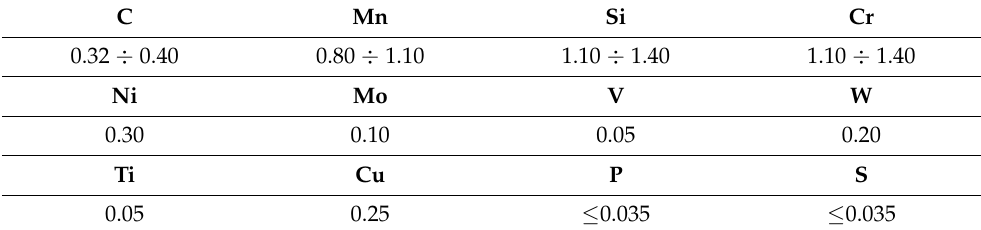
Table 4. Mechanical properties of 35HGS steel (according to PN-72/H-84030). Quantity Mark After Quenching and Tempering Tensile strength R m ≥ 1620 MPa Yield point R e ( R p0,2 ) ≥ 1280 MPa Elongation A ≥ 9% Hardness HRC max 32 Necking